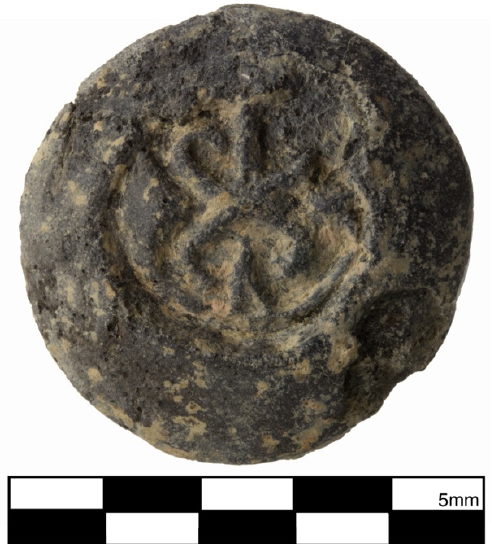
Figure 6. Stamped crossed volute decoration on an impasto rocchetto, ca. 675/650–535 BCE (Image: Poggio Civitate Project).